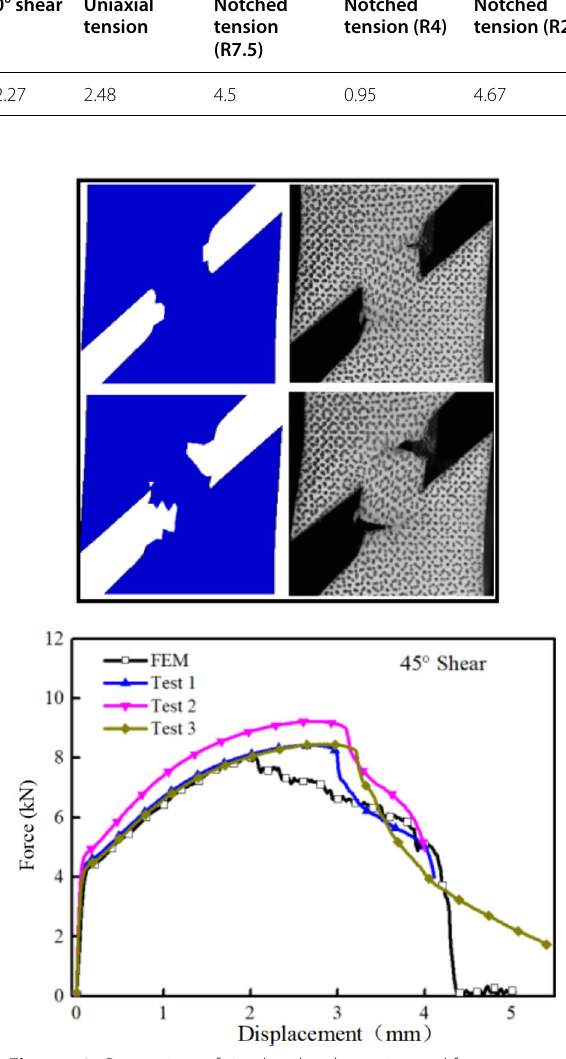
Figure 10 Comparison of simulated and experimental fracture morphology of the 45° shear specimen